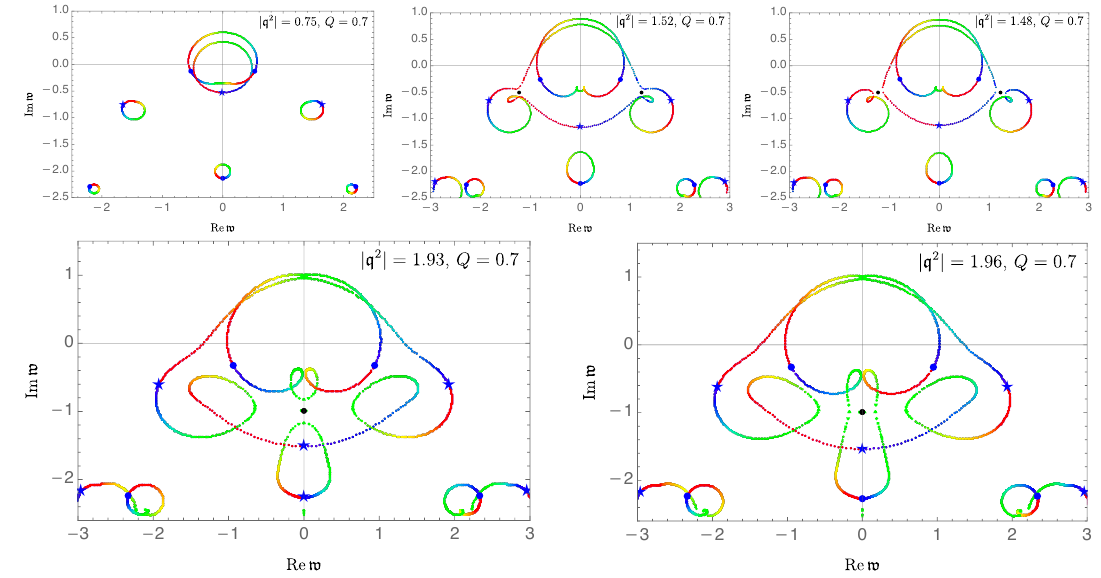
Figure 10. Poles of the retarded two-point function in the spin 0 channel at Q = 0 : 7, in the complex w (cid:0) plane, at various values of the complexi(cid:12)ed momentum q 2 = j q 2 j e i(cid:18) . Large dots and large stars correspond to the poles with purely real momentum (i.e. at (cid:18) = 0). As (cid:18) increases from 0 to 2 (cid:25) , each pole moves counter-clockwise following the trajectory whose color changes continuously from blue to red. At j q 2 j = 0 : 75 (top left panel) all poles follow closed orbits. By increasing j q 2 j , the trajectory of the hydrodynamic di(cid:11)usion pole comes close to those of the nearest star gapped poles. At j q 2 j = 1 : 48 (top middle panel) they nearly collide at the positions marked by black dots. The actual collision point is identi(cid:12)ed with the critical value of the momentum j q 2 j (cid:25) 1 : 50. It is c clear that the point ( Q = 0 : 7 ; j q c j = (1 : 50) 1 = 2 ) lies on the red curve in (cid:12)gure 7. At j q 2 j = 1 : 52 (top right panel), the orbits of the di(cid:11)usion pole and the two lowest star gapped poles are no longer closed; these poles cyclically exchanges their positions as the phase (cid:18) increases from 0 to 2 (cid:25) . This is actually the manifestation of (cid:22) J (cid:22) J (cid:0) crossing . By further increasing j q 2 j , the trajectory of sound poles come close to the that of the nearest gapped pole on the imaginary axis. At j q 2 j = 1 : 93 (bottom left panel) they nearly collide at the positions marked by black dots. The actual collision point is identi(cid:12)ed with the critical value of the momentum j q 2 j (cid:25) 1 : 95. As expected, the point c ( Q = 0 : 7 ; j q c j = (1 : 95) 1 = 2 ) lies on the blue curve in (cid:12)gure 7. At j q 2 j = 1 : 96 (bottom right panel) they exchange their positions cyclically as the phase increases from 0 to 2 (cid:25) . This is the manifestation of the (cid:22) T (cid:22) T (cid:0) crossing